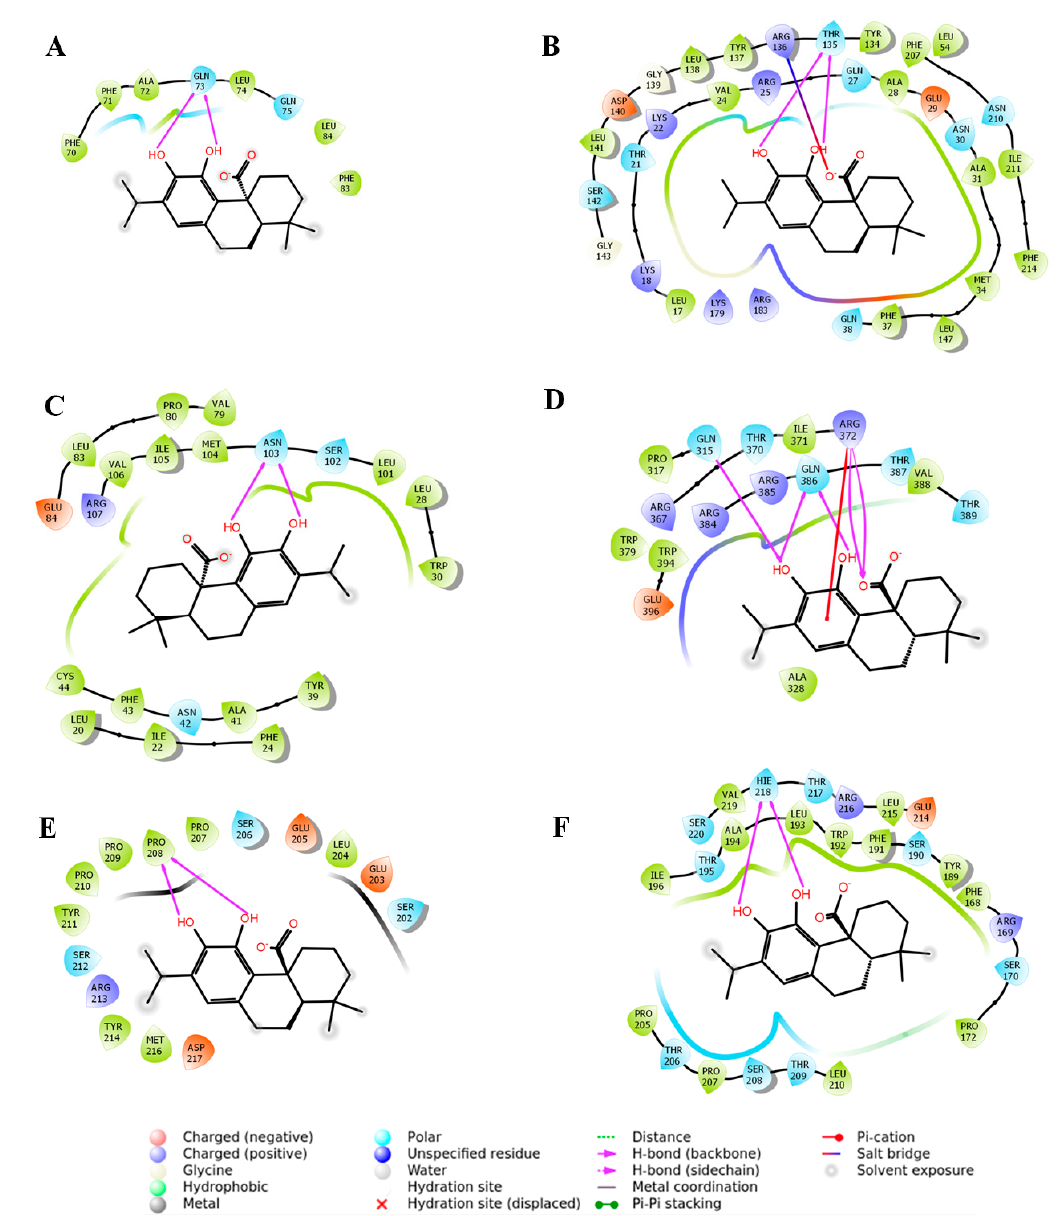
Figure 10. Molecular docking analysis revealed several types of possible molecular interactions between CA and signal proteins, such as nuclear factor erythroid 2-related factor 2 (Nrf2) ( A ), haeme oxygenase 1 (HO-1) ( B ), transforming growth factor-beta 1 (TGF- β 1) ( C ), mothers against decapentaplegic homolog 3 (Smad3) ( D ), Smad7 ( E ), and collagen IV ( F ).